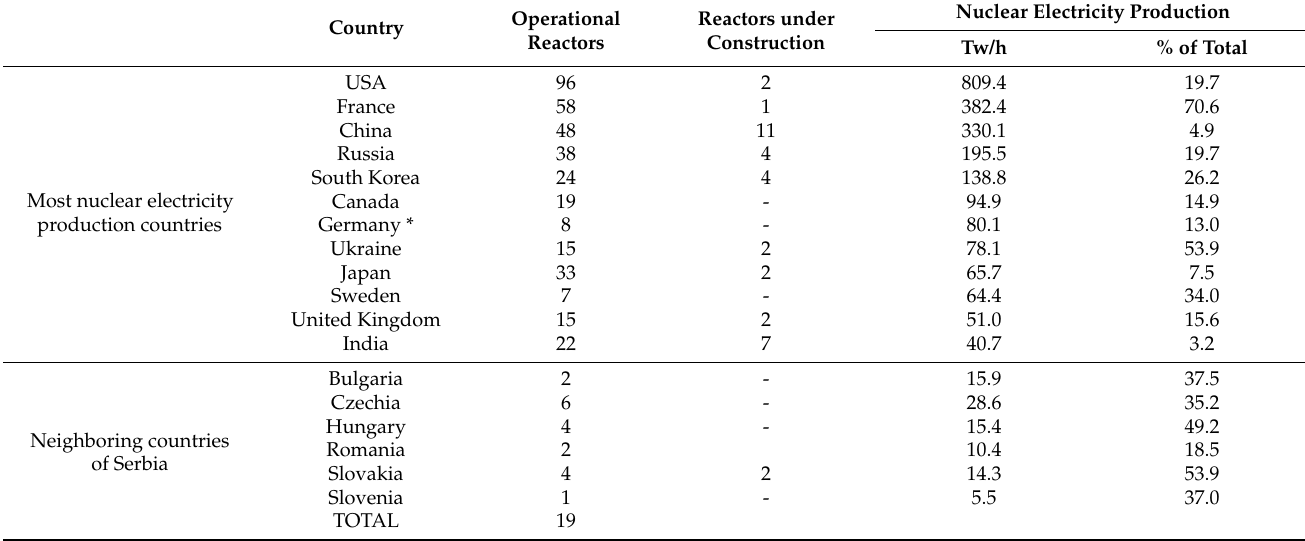
Table 1. Nuclear power plant and nuclear electricity production in some countries, 31 December 2019